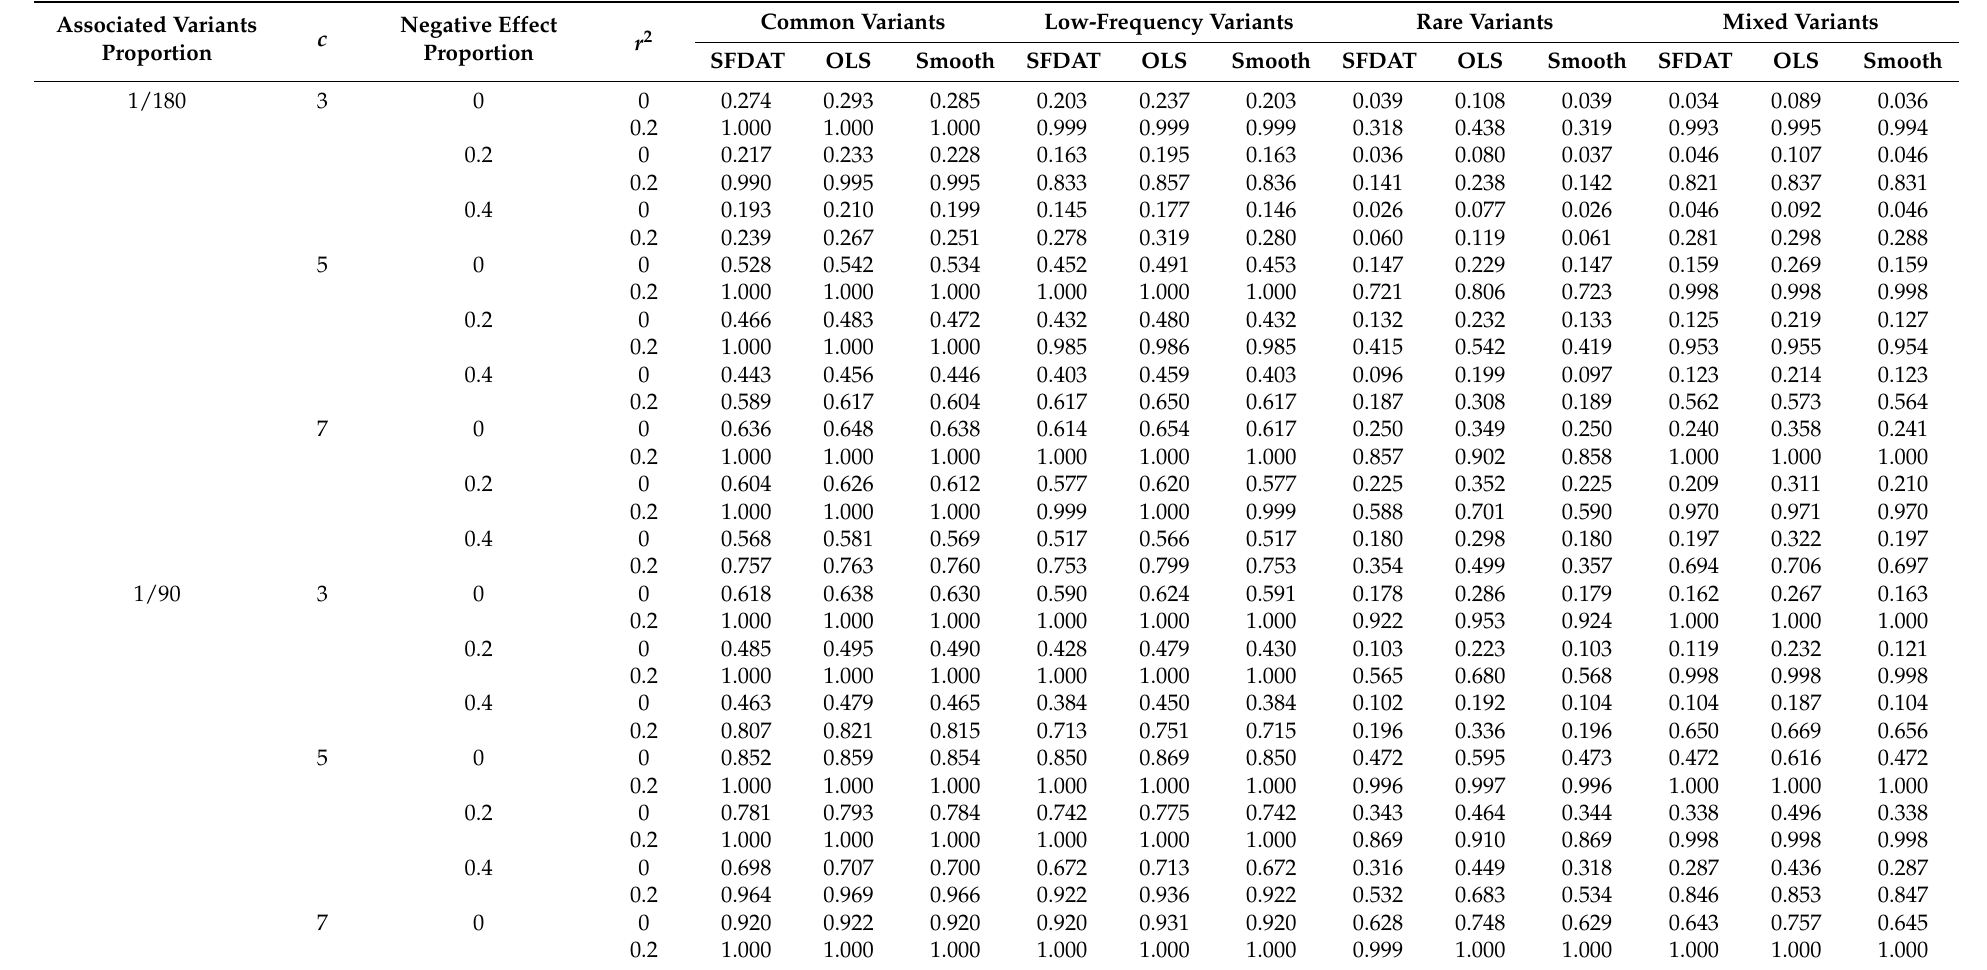
Table 1. The power of association analysis of simulated quantitative trait for linkage equilibrium and linkage disequilibrium based on SFDAT, OLS and Smooth at significance level of